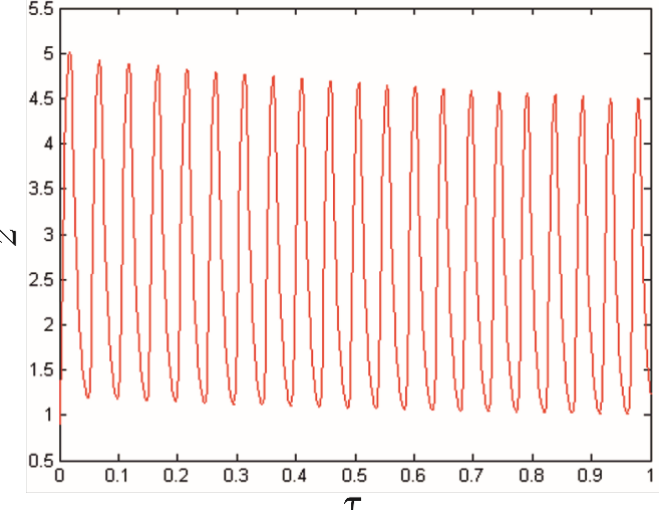
Figure 8. The evolution of the z ( τ ) concentration at high flux (α = 3000/9; β = 6/23; C = 0.001; A = 0,14 mol; M = 0.3 mol; H = 0.26 mol and k f = 6.18 × 10 −4 ) and initial values: x (0) = 0.045; z (0) = 0.9; v (0) = 0.85.